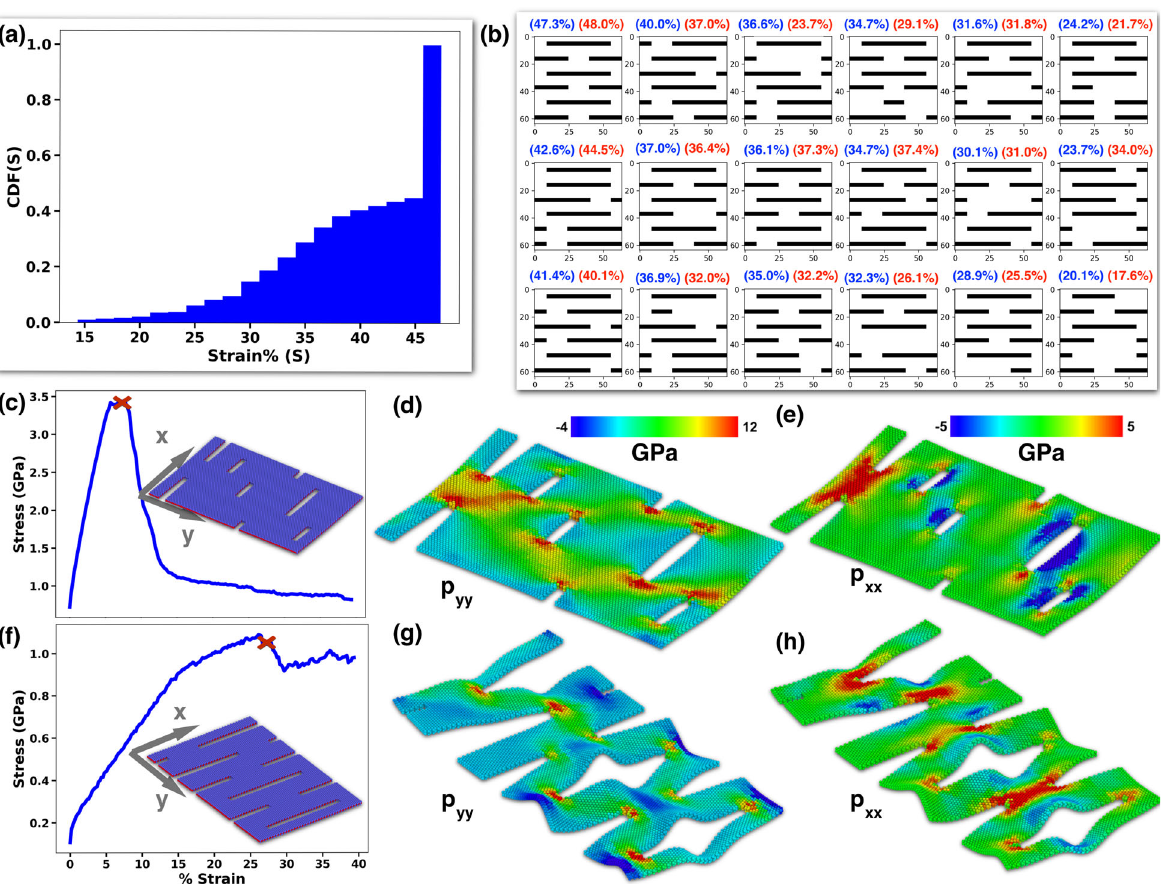
Fig. 4 MD validation of RL proposed kirigami structures with 6 cuts. a Cumulative density function (CDF) of the stretchability of systems proposed by RL for n = 6, i.e., a structure state space consisting of 13 6 structures. b Top 18 structures proposed by the RL agent for n = 6. Here, structures are sorted by their stretchability (S) and blue and red values above the structures are their S value computed by the dynamic model and MD simulation, respectively. Stress – strain curve, deformation mechanism, and local stress distribution, p xx and p yy , inside the materials before failure for system showing brittle failure and have low stretchability in ( c – e ) and for system showing ductile failure and have high stretchability in ( f – h